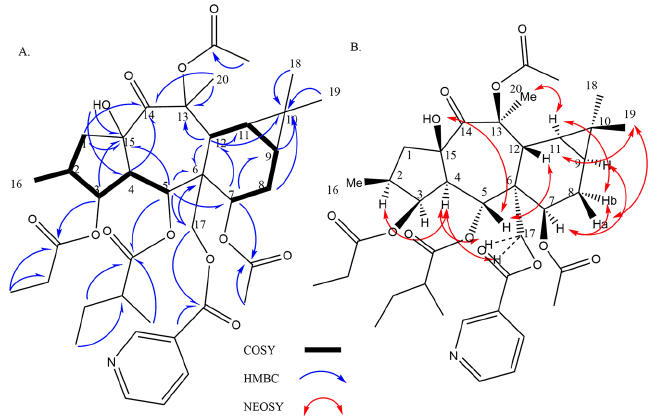
Figure 3. ( A ) Selected HMBC and COSY correlations and ( B ) representation of key NOESY cross peaks of 1. Compound 2 was isolated as a colorless oil with optical rotation +70.0 (c 0.03 EtOAc),